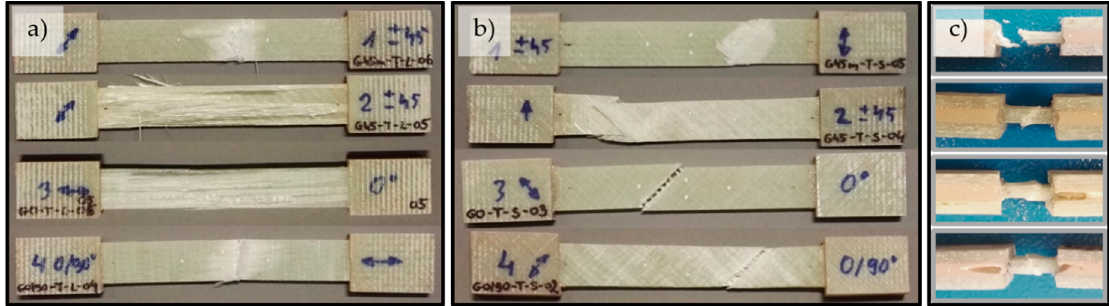
Figure 6. Typical tensile failure modes of glass composite specimens (from the top): X-S-E-1109-1270, X-E-1210-1270, U-E-600-1200, and B-E-641-1300 for ( a ) tensile, ( b ) shear, and ( c ) compression. Table 4. Test results in the second stage of the research.